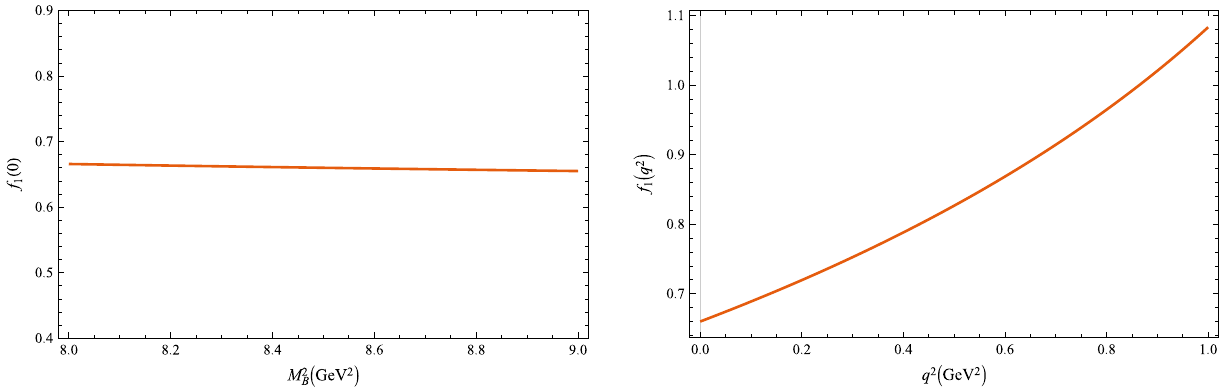
< 9GeV 2 (left), and the form factor f B